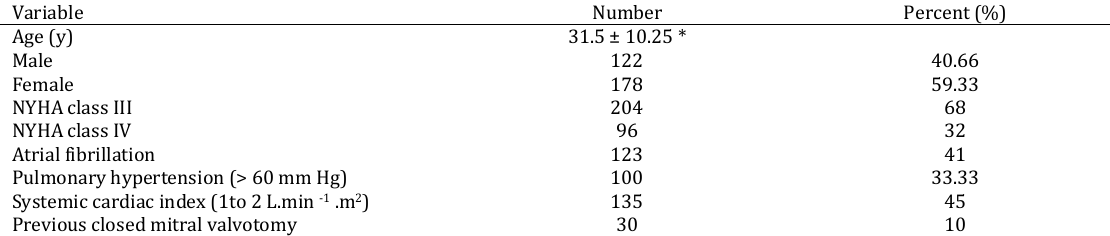
Table 1. Preoperative clinical data